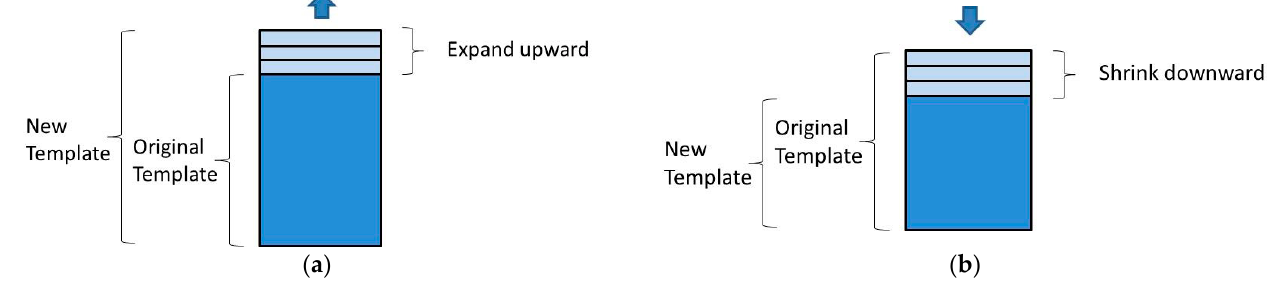
Figure 4. Adaptive adjustment of the top side of the template in the ADMTCF algorithm: ( a ) expanding upward; ( b ) shrinking downward. Figure 5. Adaptive adjustment of the bottom side of the template in the ADMTCF algorithm: ( a ) expanding downward; ( b ) shrinking upward.